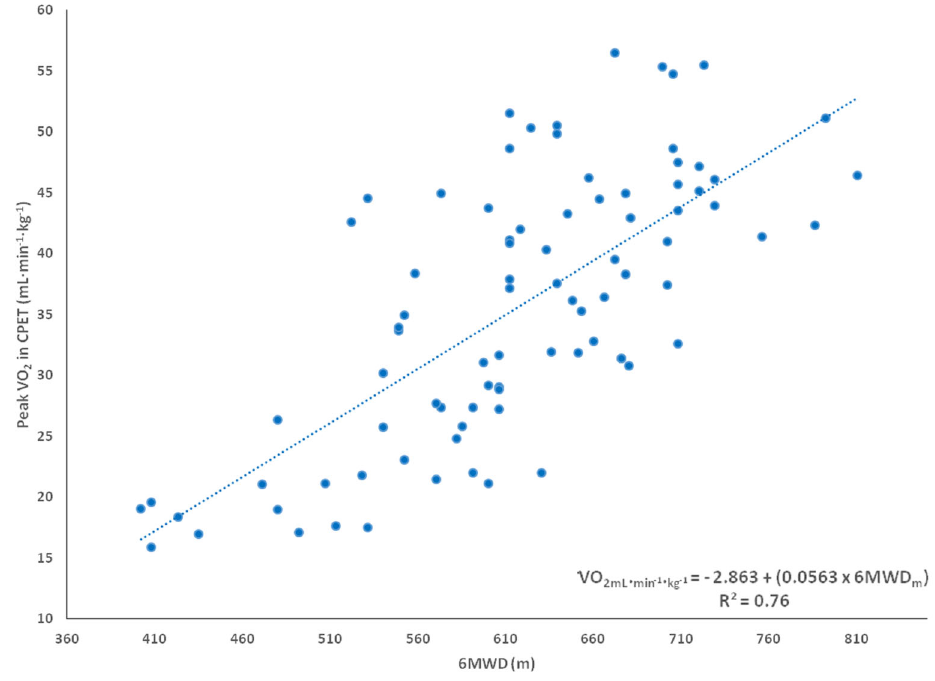
Figure 1. Significant relationship (P , 0.001) between the 6-min walk distance (6MWD) and peak oxygen uptake in cardiopulmonary exercise testing